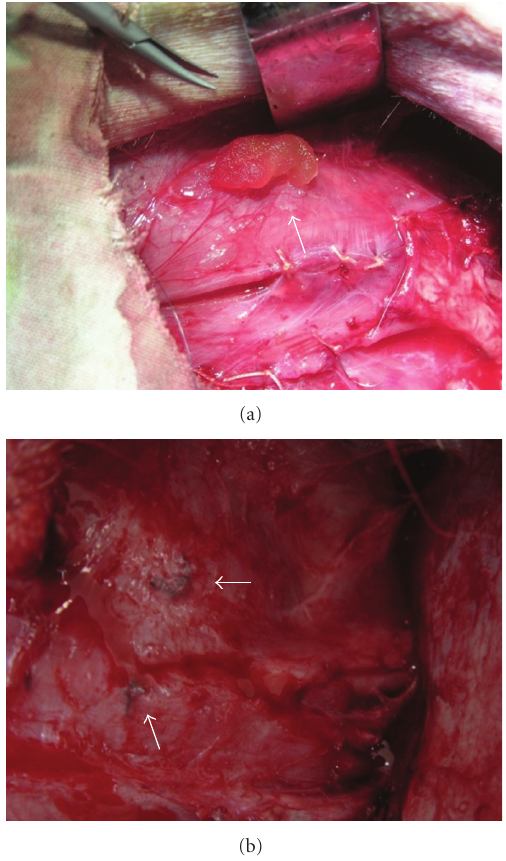
Figure 3: (a) bFGF-CM was being implanted into the ischemic hindlimb muscle, the implanted sites were stitched as markers for samples collection. (b) At harvest, ischemic hindlimb tissue regenerated well; the stitched markers indicated the bFGF-CM implantation